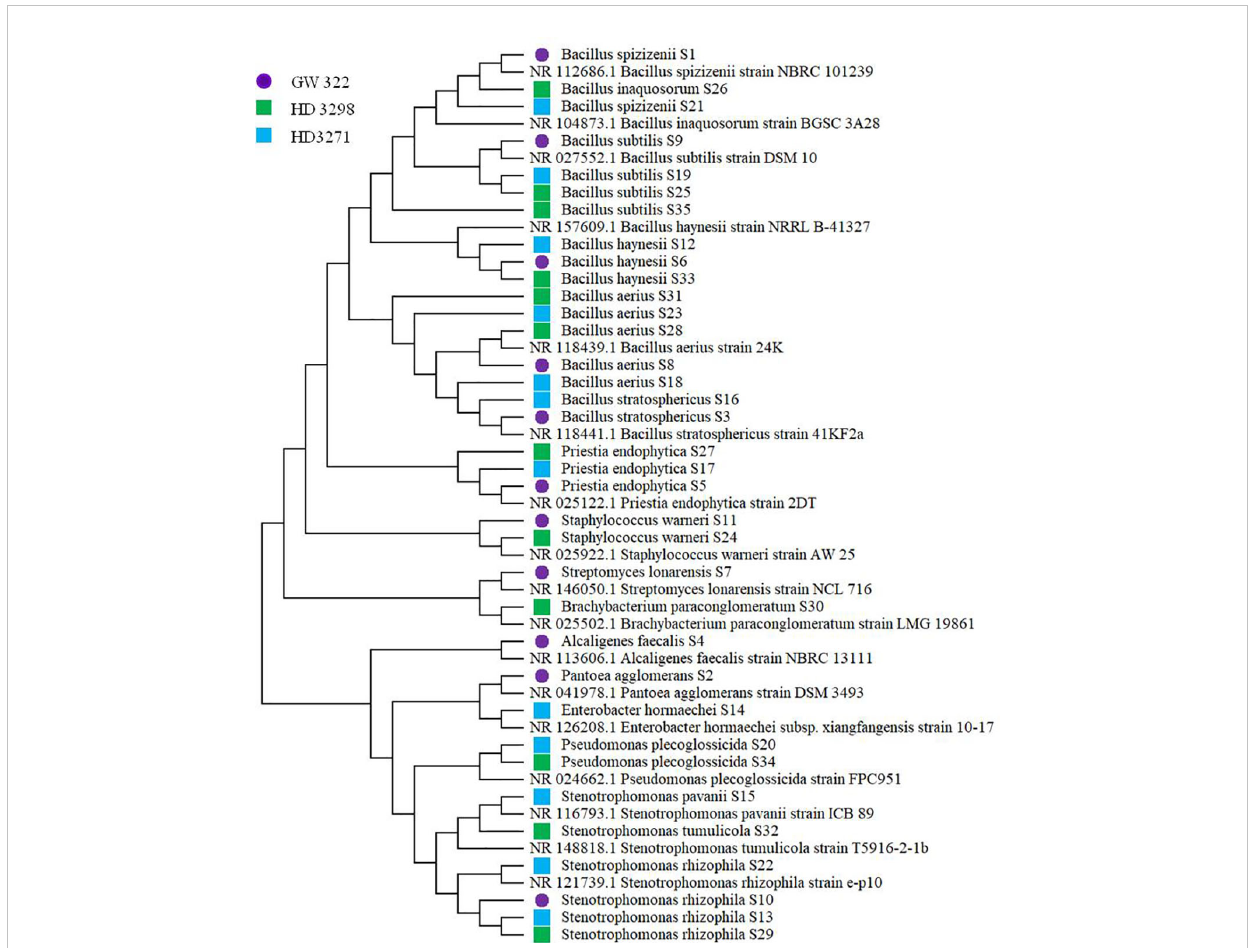
FIGURE 5 Phylogenetic tree of identi fi ed heat T WSEB isolates from wheat varieties — heat S (GW322) and heat T (HD3298 and HD3271) [constructed using neighbor joining algorithm with 1,000 bootstrap values. *Purple fi lled circle (S1 to S11) — isolates from heat S (GW322) variety, green fi lled square (S12 to S23) — isolates from heat T (HD3298) variety, and blue fi lled square (S24 to S35) — isolates from heat T (HD3271)